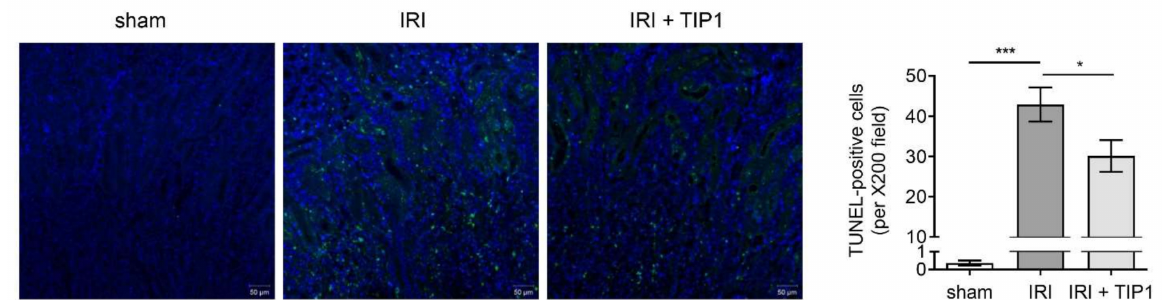
Figure 3. Protective effects of TIP1 against apoptosis in kidney ischemia-reperfusion injury. TUNEL staining and quantifica- tion of the number of TUNEL-positive cells in the harvested kidneys 24 h after IRI. Nuclei were counterstained with DAPI (blue). Data are expressed as mean ± SEM. Sham ( n = 6), IRI ( n = 6), and IRI-TIP1 ( n = 6). * p < 0.05, *** p < 0.001. Scale bar = 50 µ m. TLR-inhibitory peptide 1 (TIP1); terminal deoxynucleotidyl transferase-mediated deoxyuridine triphosphate nick-end labeling (TUNEL); 4 (cid:48) ,6-diamidino-2-phenylindole (DAPI).